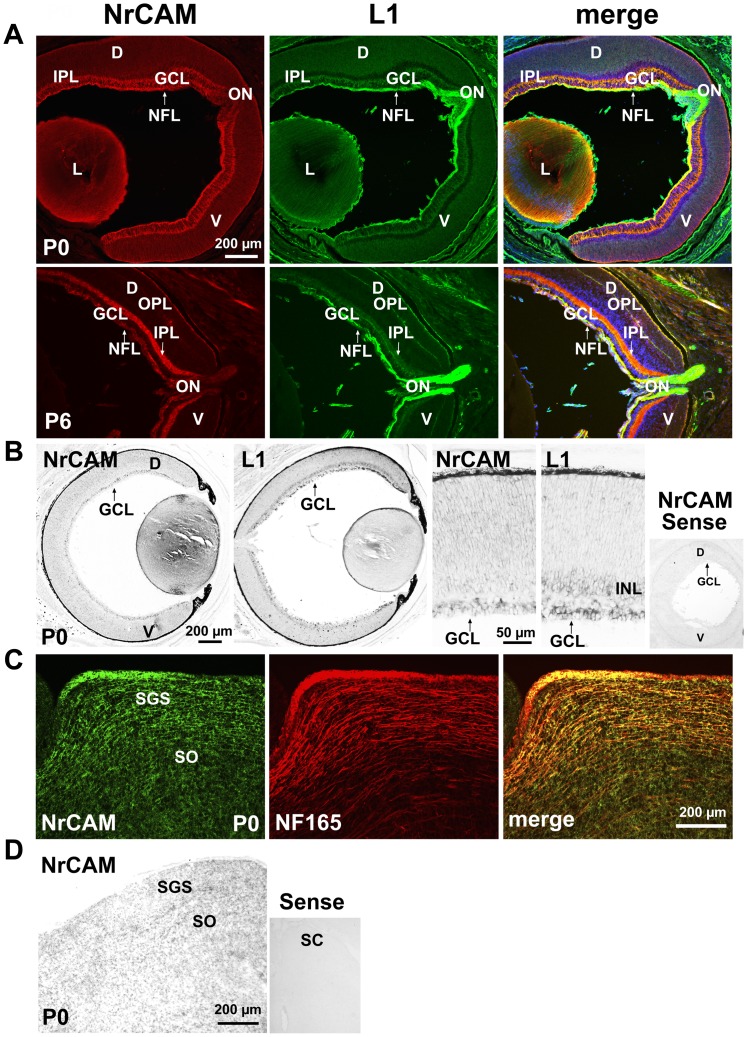
Early Postnatal Expression of NrCAM in the Retina and Superior Colliculus.
A. Immunofluorescence staining for NrCAM (red) in mouse retina at P0 and P6 demonstrated NrCAM localization in fibers of the retinal NFL, ON, IPL, and lens, as shown in confocal images. Double staining for L1 (green) showed partial co-localization with L1. GCL, ganglion cell layer; NFL, nerve fiber layer; IPL, inner plexiform layer; ON, optic nerve head; OPL, outer plexiform layer; L, lens; D, dorsal; V, ventral. B.
In situ hybridization with antisense probes in the mouse retina (P0) showed NrCAM transcripts in cell bodies in the GCL. L1 transcripts were present in the GCL and inner nuclear layer (INL). Background labeling of retina is shown by hybridization with the NrCAM sense probe. C. Immunofluorescence staining for NrCAM in sagittal sections of SC at P0 showed partial co-localization with the axonal marker NF165 in a portion of RGC axons in the SGS and SO, as well as some additional labeling within the SC. SGS, stratum griseum superficiale; SO, stratum opticum. D.
In situ hybridization with antisense probe showed NrCAM transcripts in cell bodies located within the SC (P0, sagittal sections). Background is indicated by hybridization with the NrCAM sense probe.